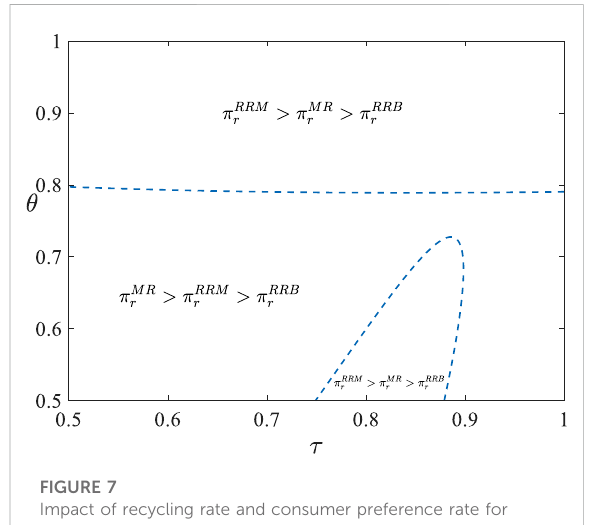
FIGURE 7 Impact of recycling rate and consumer preference rate for remanufactured products on the retailer ’ s pro fi